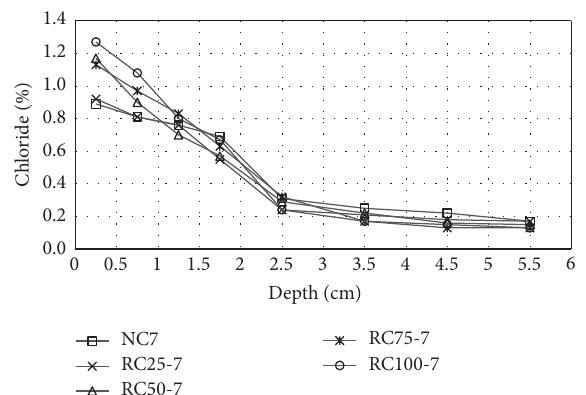
Figure 10: Chloride profiles for 0.7 w/c.